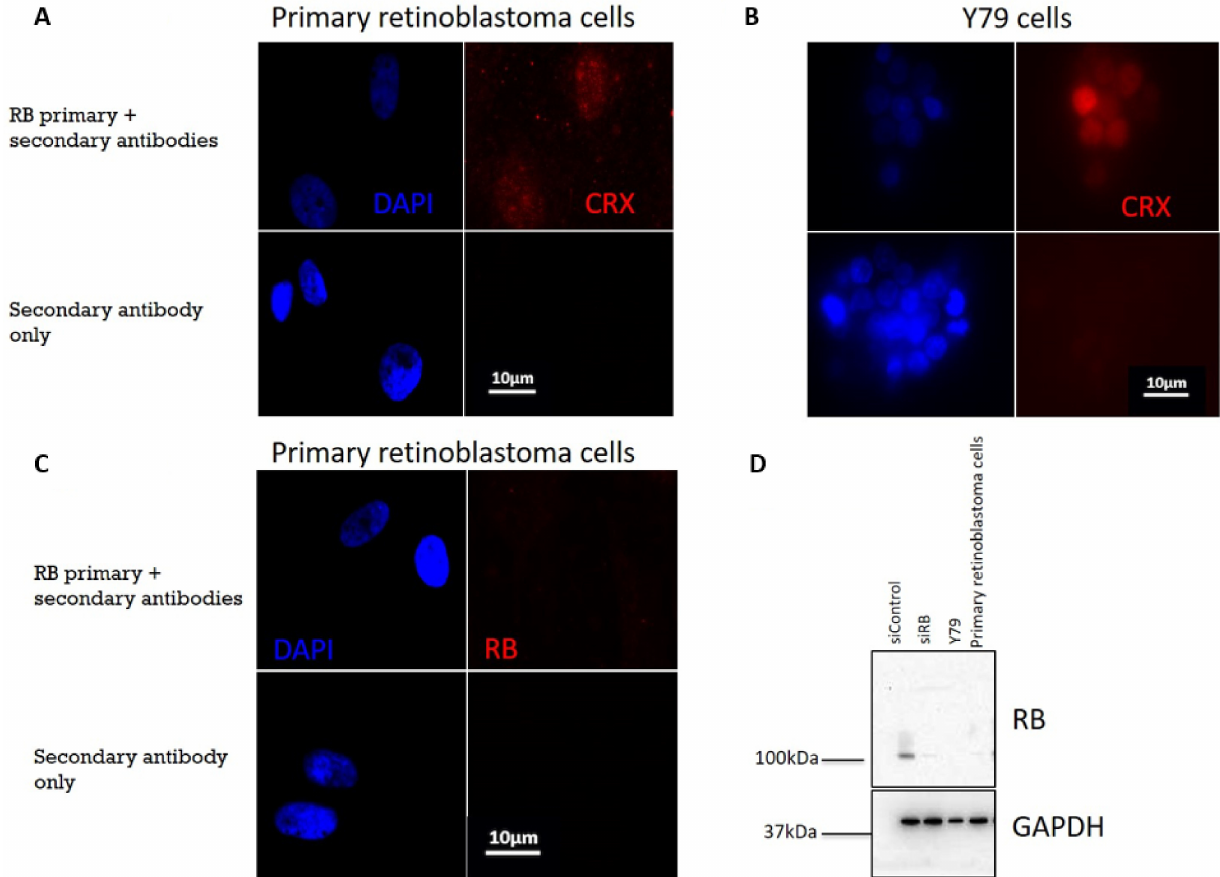
Figure 4. ( A ) Immunofluorescence staining detected CRX (red) in primary retinoblastoma cells. ( B ) CRX (red) was also detected in Y79 cells. ( C ) Immunofluorescence staining showed loss of RB signal (red) in primary retinoblastoma cells. Nuclei were stained with DAPI (blue). ( D ) RB was only detected in control siRNA (siControl)-treated U2OS cells. No RB could be detected in RB knocked-down (siRB) U2OS cells, Y79 cells or primary retinoblastoma cells. GAPDH was used as the loading